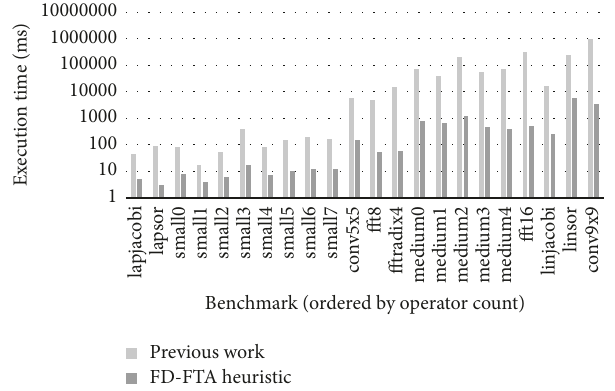
Figure 9: Clock frequency of the three approaches in a subset of nonsynthetic benchmarks under 1x and 2x normalized latency constraints and a 100% EC